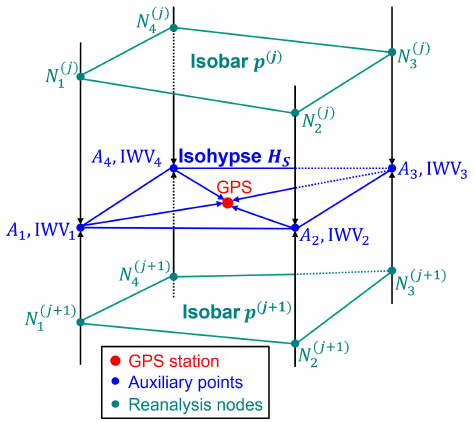
Figure 2. Schematic plot of the vertical and horizontal interpolation of the reanalysis pressure-level products. The IWV at each auxiliary point ( A i ; orange dots) is calculated with vertical interpolation or extrapolation of the adjacent reanalysis nodes ( N ( j ) green dots). The IWV at the GPS station (red dot) is then estimated with horizontal interpolation of the auxiliary